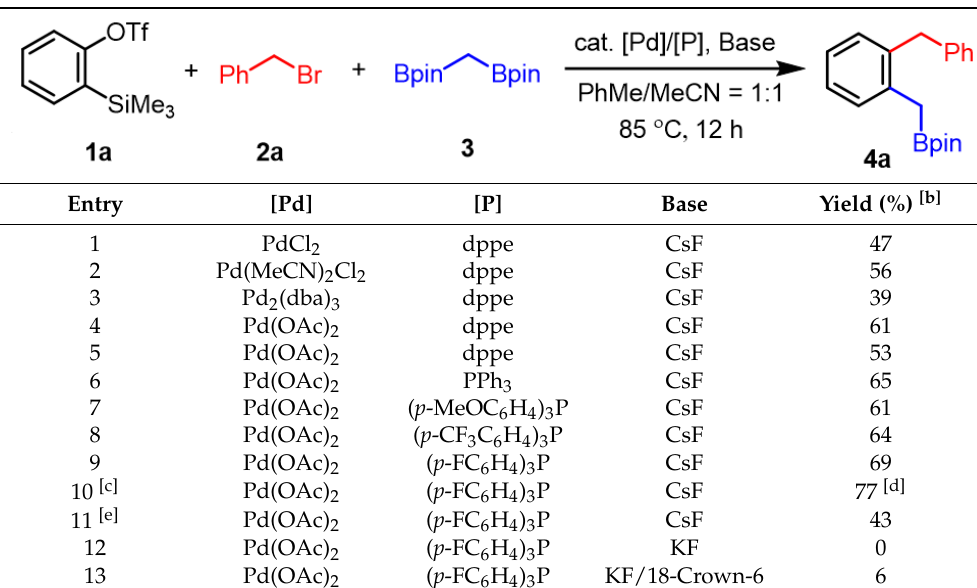
Table 1. Reaction condition optimization [a] .